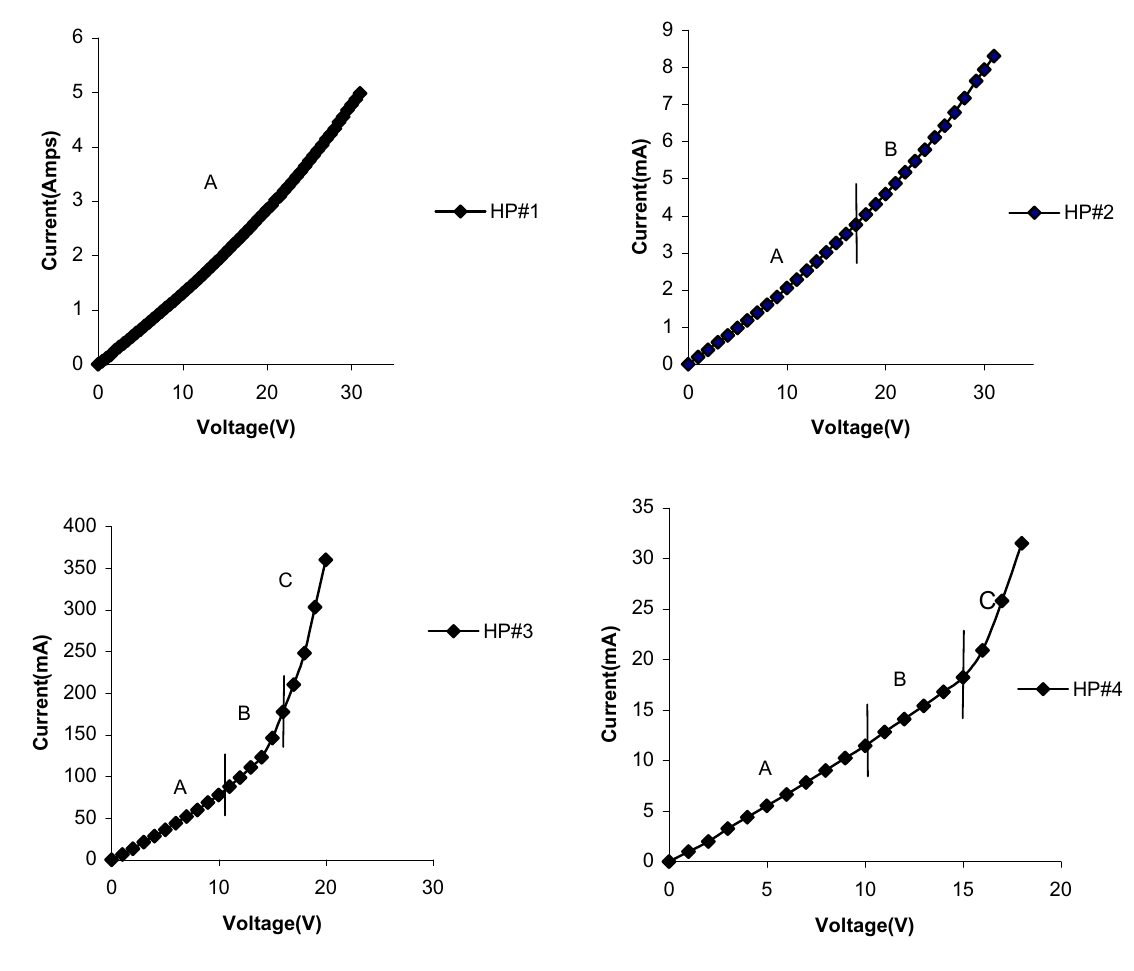
Figure 8. I-V plots for the In